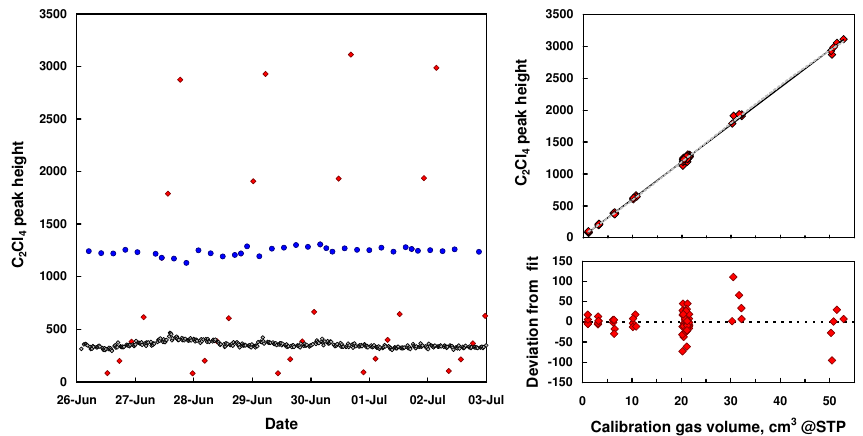
Fig. 5. (left) Typical µ Dirac calibration / sampling sequence showing raw peak height data for tetrachloroethene (from 26th June to 3rd July 2009, during remote operation at Bukit Atur, Malaysia). Sample peak heights are shown as grey circles. Precision calibrations (blue circles) are used to derive measurement precision and to enable correction to sensitivity drift. The response calibrations (red diamonds) are used to make corrections for non-linearity. (right) The response calibration peak heights plotted against volume of calibration gas. The solid black line shows the linear fit and the dashed grey line is a 3rd order polynomial fit. The lower panel shows the deviations of the individual calibrations from the linear fit and more clearly shows any departure from linear behaviour, the dashed black line in this panel is a linear fit through the deviations. Note that we anyway use the 3rd order polynomial fit to correct the samples for non-linearity effects.